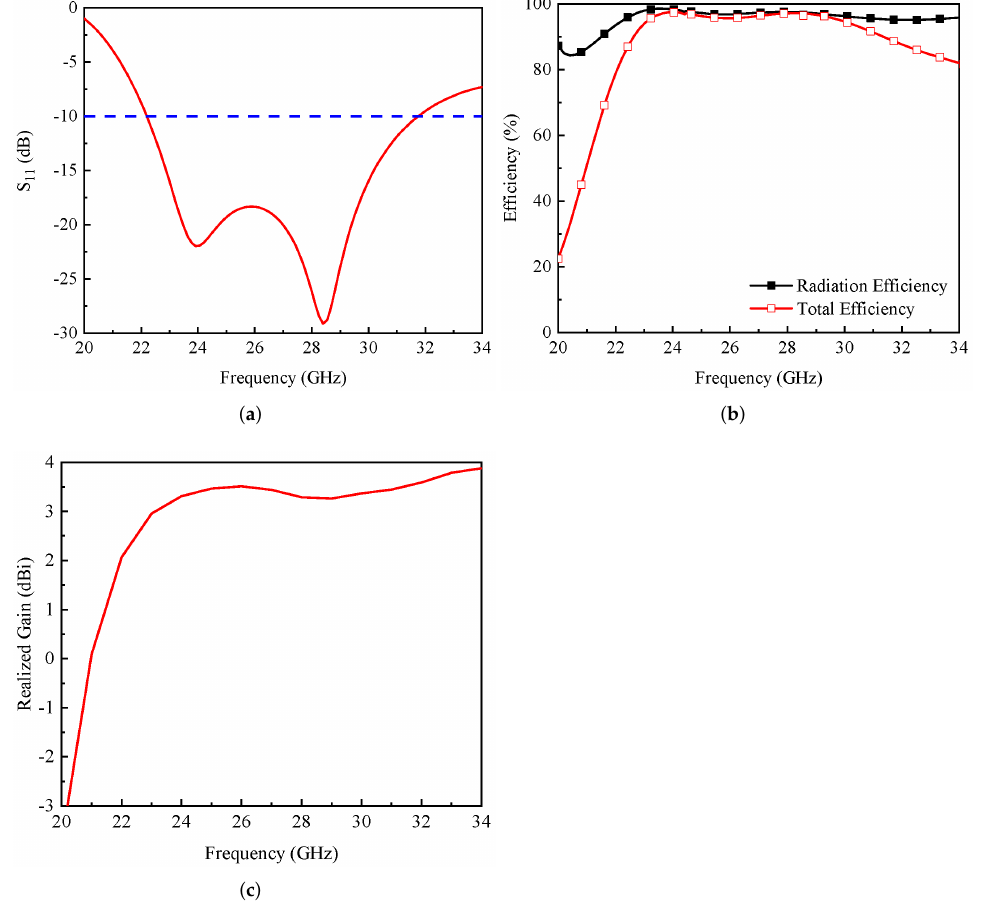
Figure 2. Simulated ( a ) S 11 , ( b ) radiation and total efficiency, and ( c ) realized gain of the proposed